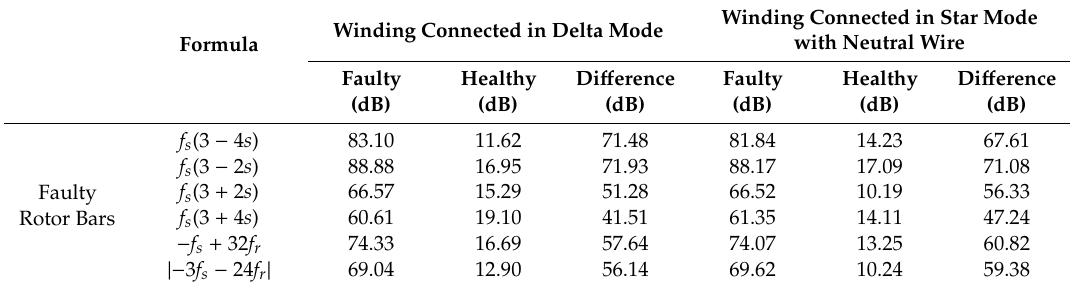
Table 4. Results of harmonic amplitude measurements of characteristic frequencies for a rotor cage fault obtained from finite element analysis of a motor with delta and wye connections with a neutral wire stator winding